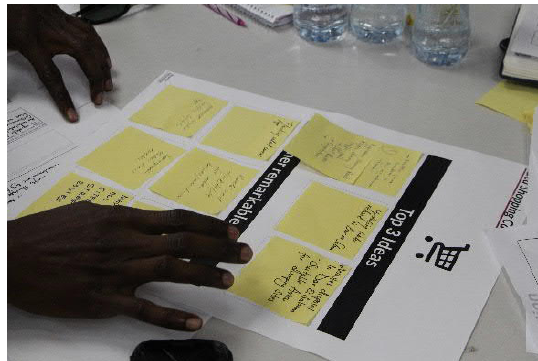
Figure 6. Geospatial Business Hackathon was organised in at Buni Hub in order to develop possible business solutions around location-related urban problems, such as delivery services (April 2016).